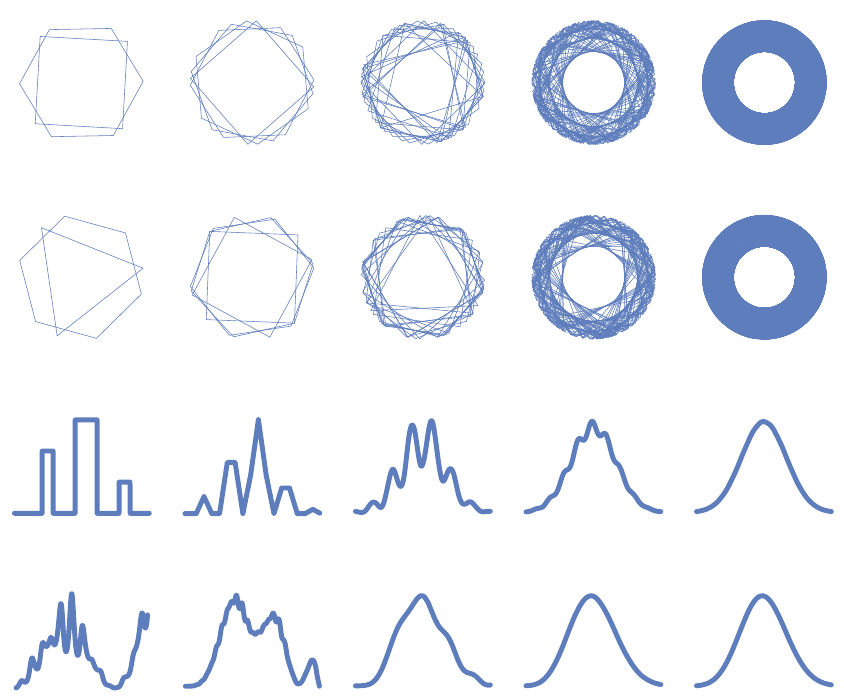
Figure 4. Aggregation and asymptotic invariance. The top shows polygons randomly rotated about their center. Aggregation leads asymptotically to loss of all information about rotational orientation. A circle purely expresses that rotational invariance. The bottom shows the aggregate summing of observations from arbitrary probability distributions. Aggregates combine to produce normal distributions, purely expressing the loss of all information except the average distance (variance) from the most common observation. The normal distribution is invariant to the order in which observations are combined. Order invariance is similar to rotational invariance (Figure 5). Thus, the asymptotic circle and the asymptotic normal distribution express similar aspects of information loss and